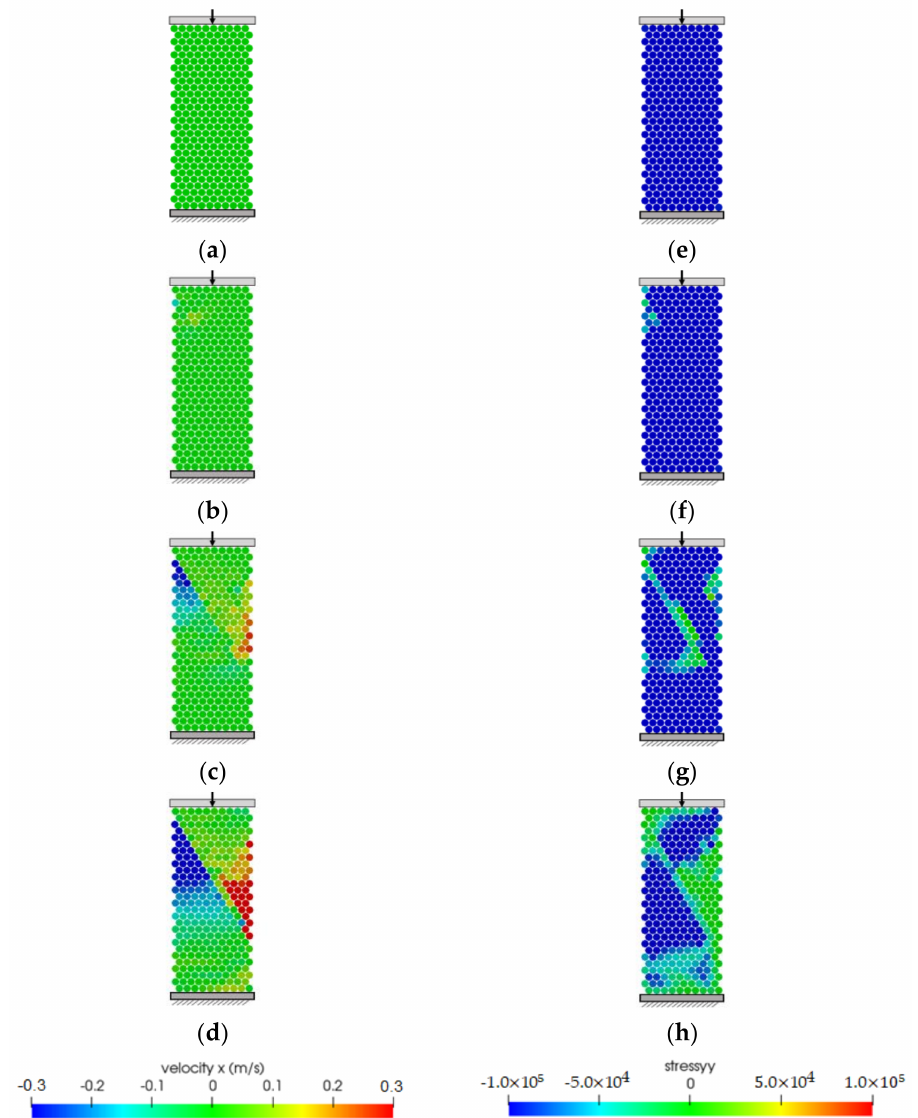
Figure 4. Failure process of uniaxial compressive test: left column presents x -directional velocity; right column presents normal stress in the y -direction. ( a ) t = 0.2987 s; ( b ) t = 0.2988 s; ( c ) t = 0.2989 s; ( d ) t = 0.2990 s; ( e ) t = 0.2987 s; ( f ) t = 0.2988 s; ( g ) t = 0.2989 s; ( h ) t = 0.2900